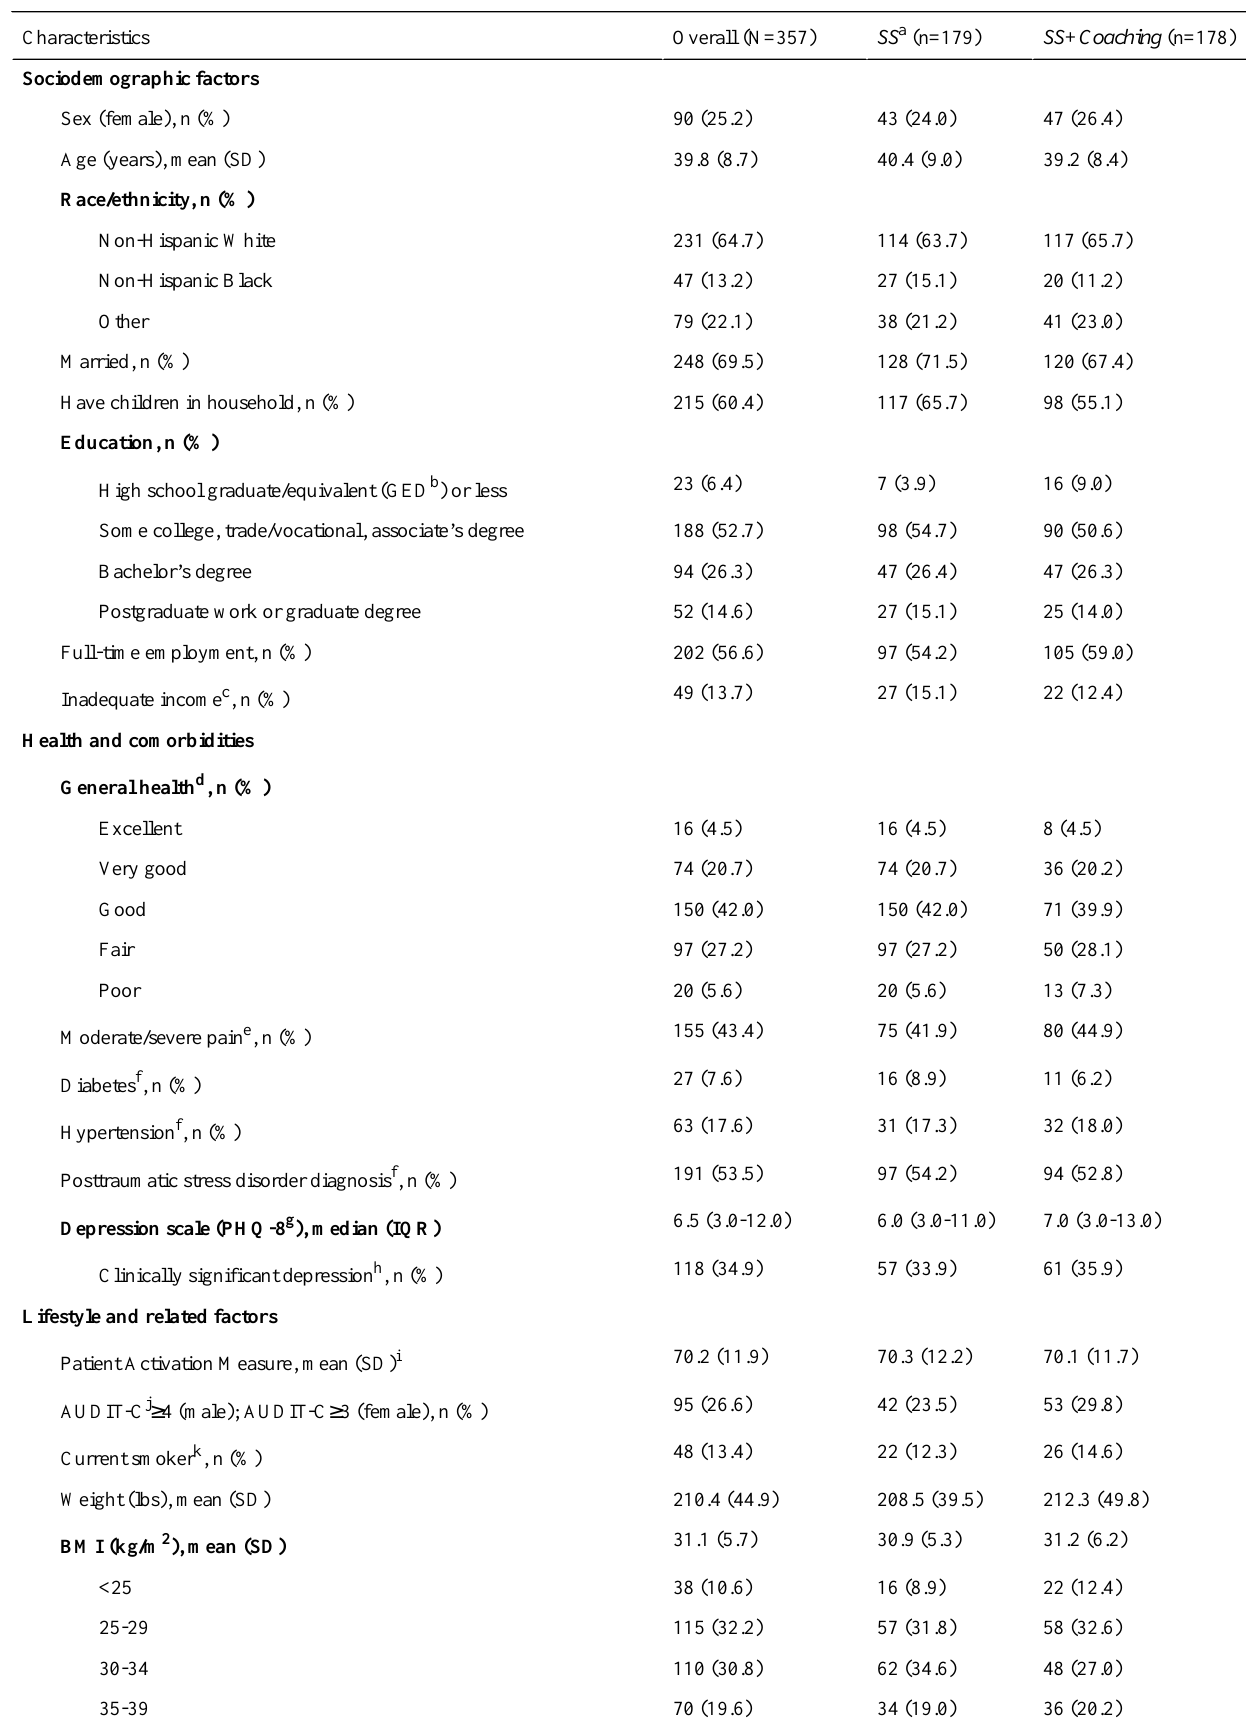
Table 2. Baseline characteristics of participants